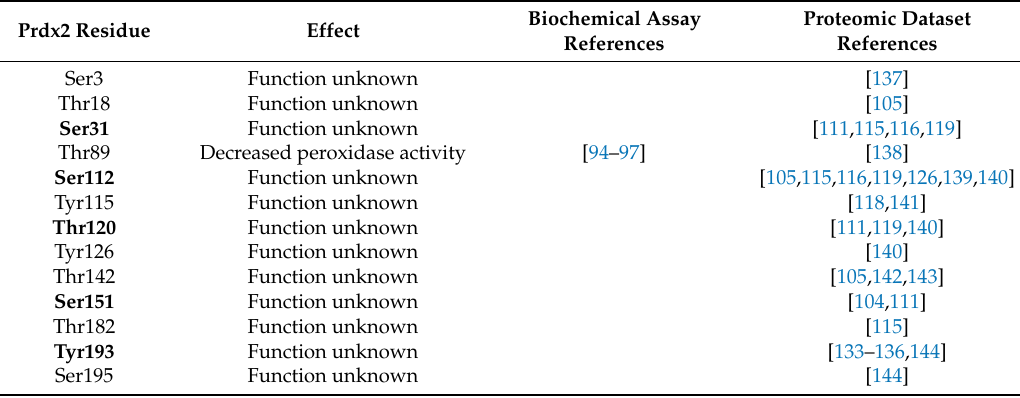
Table 2. Phosphorylation of Prdx2 can decrease peroxidase activity to coordinate cell signaling. Phosphorylation sites that correspond to human Prdx2 in biochemical assays and proteomic studies are referenced are indicated. Phosphorylation sites that have been identified in proteomic screens in cancer models are in